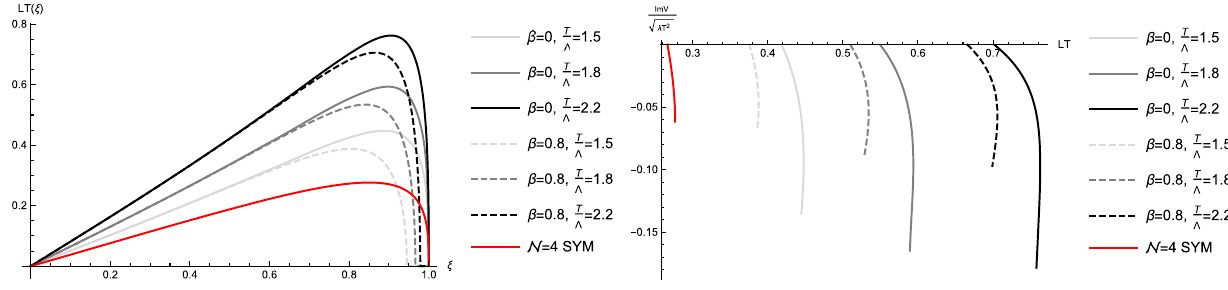
√ / λ T versus LT for different values of QQ